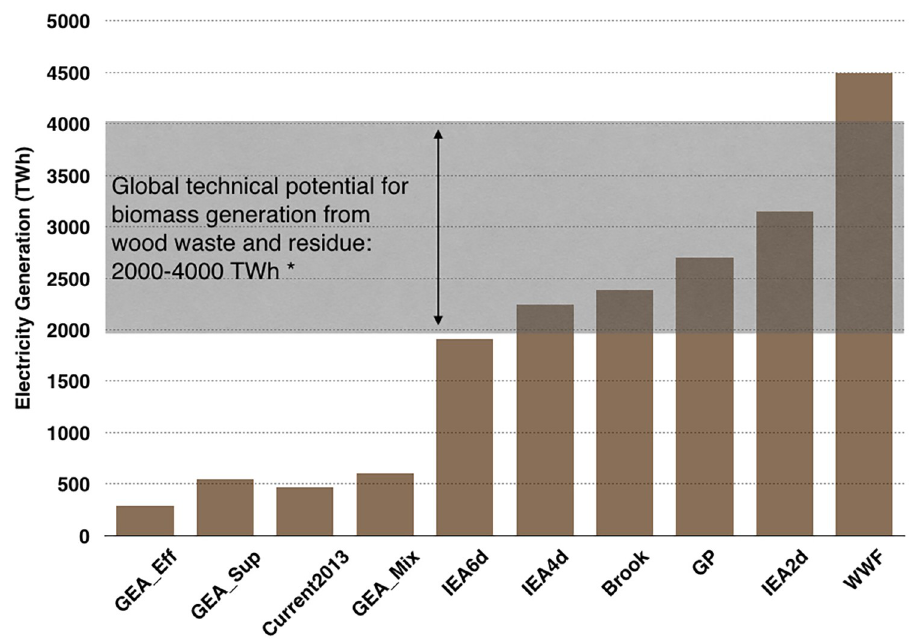
Fig 4. Amount of electricity sourced from biomass in each of the scenarios we evaluated. Most scenarios do not specify whether the biomass will be sourced from dedicated crops or managed forests, or sourced from waste and residue. However, several scenarios include more biomass combustion than could be reasonably sourced from waste and residues, assuming all waste and residue produced globally could be economically collected. � Global technical potential for biomass production comes from Searchinger and Heimlich